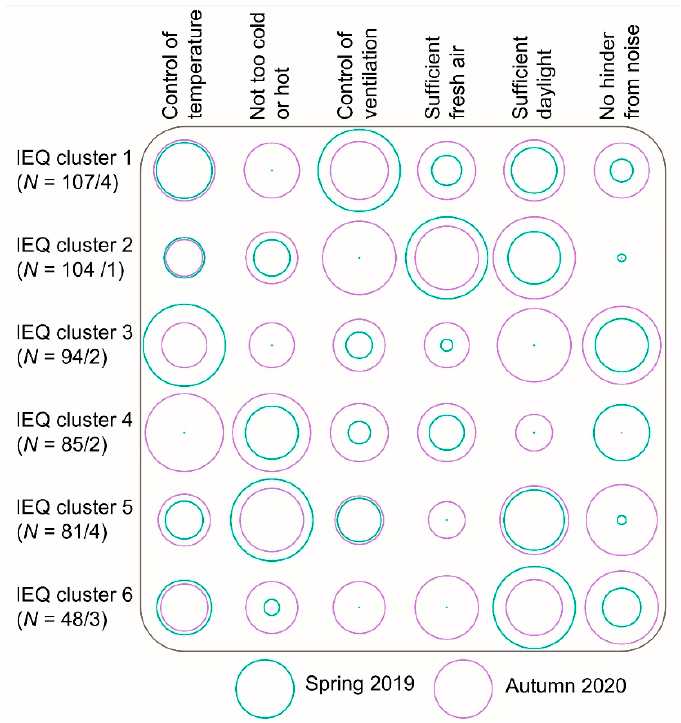
Figure 7. Proportion of preferences selected per IEQ cluster in 2019 and average rating of preferences in 2020.